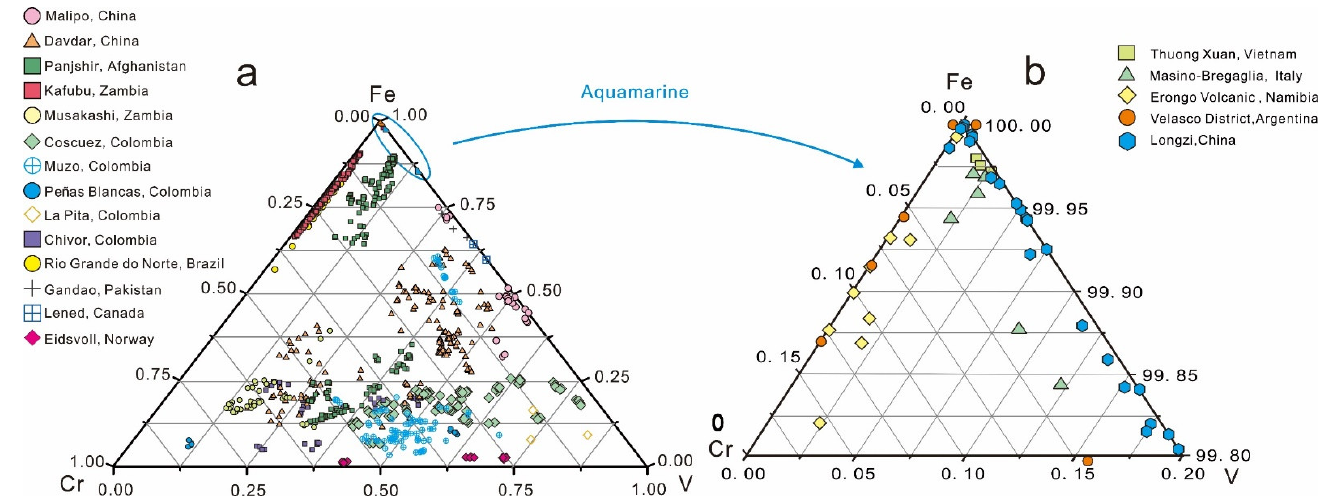
Figure 14. ( a , b ) Compared with emerald, the chromogenic elements of aquamarine are single, and the Cr and V contents of aquamarine are very low. Other sources are [18–20,22,56–62].